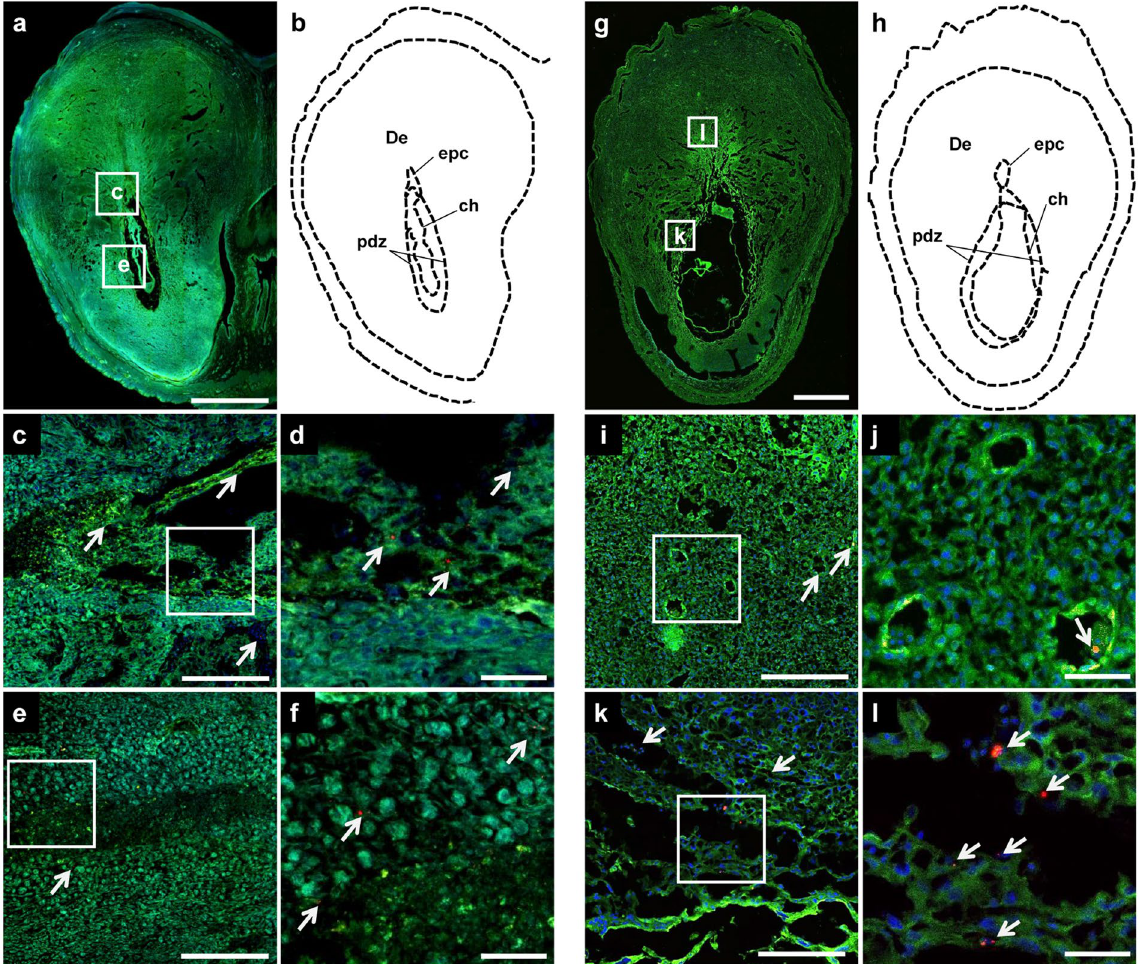
Figure 4. ( a – f ) PGMA and ( g – l ) PGMA-PEI nanoparticles in the ED10 conceptus. ( a ) Representative tissue section of a conceptus from a PGMA treated dam. ( b ) Outline of section denoting tissue regions. ( c – e ) Higher magnification images of the areas shown in the rectangles in ( a ). ( d , f ) High magnification images of panels ( c ) and ( e ) respectively. PGMA nanoparticles (indicated by arrowheads) were observed in the ectoplacental cone as well as in the primary decidual zone. ( g ) Representative tissue section of a conceptus from a PGMA-PEI treated dam. ( h ) Outline of section denoting tissue regions. ( I , k ) Higher magnification images of the areas shown in the rectangles in ( g ). ( j , l ) High magnification images of panels ( i ) and ( k ) respectively. PGMA-PEI nanoparticles (indicated by arrowheads) were observed in the decidua, specifically in the venous sinusoids and tissue close to the ectoplacental cone as well as in the primary decidual zone. Scale bars: ( a , g ) 1000 µ m; ( c , e , i , k ) 200 µ m; ( d , f , j , l ) 50 µ m. De: decidua; ch: chorion; epc: ectoplacental cone; pdz: primary decidual zone. Images are representative of n = 4 per